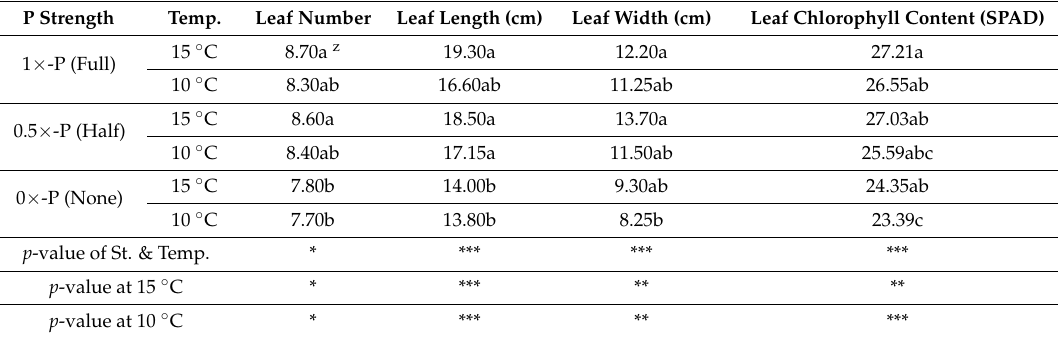
Table 5. Leaf number, leaf length, leaf width and leaf chlorophyll content (SPAD) of red romaine lettuce at harvest day (28 days after